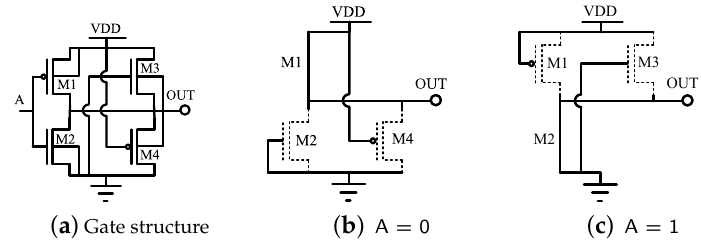
Figure 2. BSPL NOT gate, and the status of the transistors for different inputs.